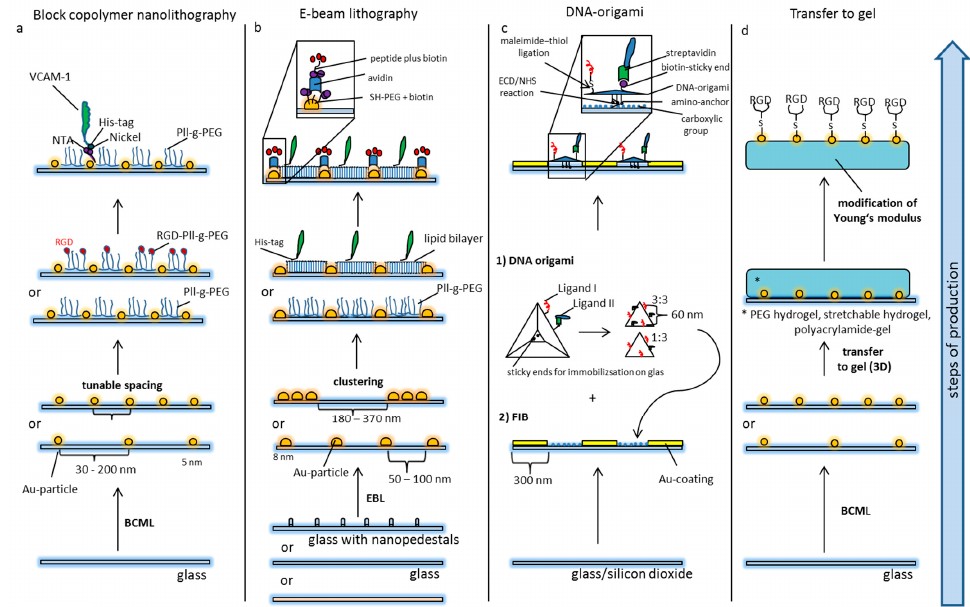
Figure 2. Principles of nanostructured models of cellular and extracellular matrices. ( a ) Block-copolymer nanolithography (BCML): Glass slides are covered with 5 nm gold particles by BCML. The advantages of this method are the high production rate and the flexible tunable densities of Au nanoparticles. The area in-between the nanodots is passivated by pegylation preventing unspecific protein adsorption. The Pll-g-PEG layer can also be spiked with additional ligands, or ligands can be unmasked via click chemistry. The Au-particles serve as anchor points for the site-directed display of ligands via creating an NTA–Nickel–His–tag complex. ( b ) Electron beam lithography: Glass slides are nanopatterned by electron beam lithography. Based on different production processes, modifications like nanopedestals (for the axial presentation of ligands) or alternative materials like silicon have been used. The general design of the patterns (distribution of particles) can vary. Pll-g-PEG in-between the particles prevents unspecific binding, or a second ligand can be presented using artificial lipid bilayers. The Au-particles can be functionalized by thiol–PEG carrying biotin moieties. The latter can ligate avidin for immobilization of biotin-tagged peptides or proteins. ( c ) Focused ion beaming in combination with DNA origami: For the immobilization of DNA origami, glass substrates containing silicon dioxide are patterned with an Au-surface using focused ion beaming (FIB). The silicon in-between is further prepared to present carboxylic groups for the covalent ligation of the amino anchors of the DNA-origami (EDC-NHS reaction). The DNA origami itself is produced by the self-assembly of single DNA strands which are forced into a certain configuration by short congruent DNA strands. The distance of functional groups can be pre-determined on the nanoscale, and the amount and relation of ligands can be adjusted. Different ligands can be functionalized by distinct forms of peptide immobilization, e.g., maleimide-thiol ligation on the one hand and biotin-streptavidin ligation on the other. ( d ) Transfer of nanopatterns to gel: Nanopatterns can be transferred to different gels. Especially nanopatterns produced by BCML have been used for this